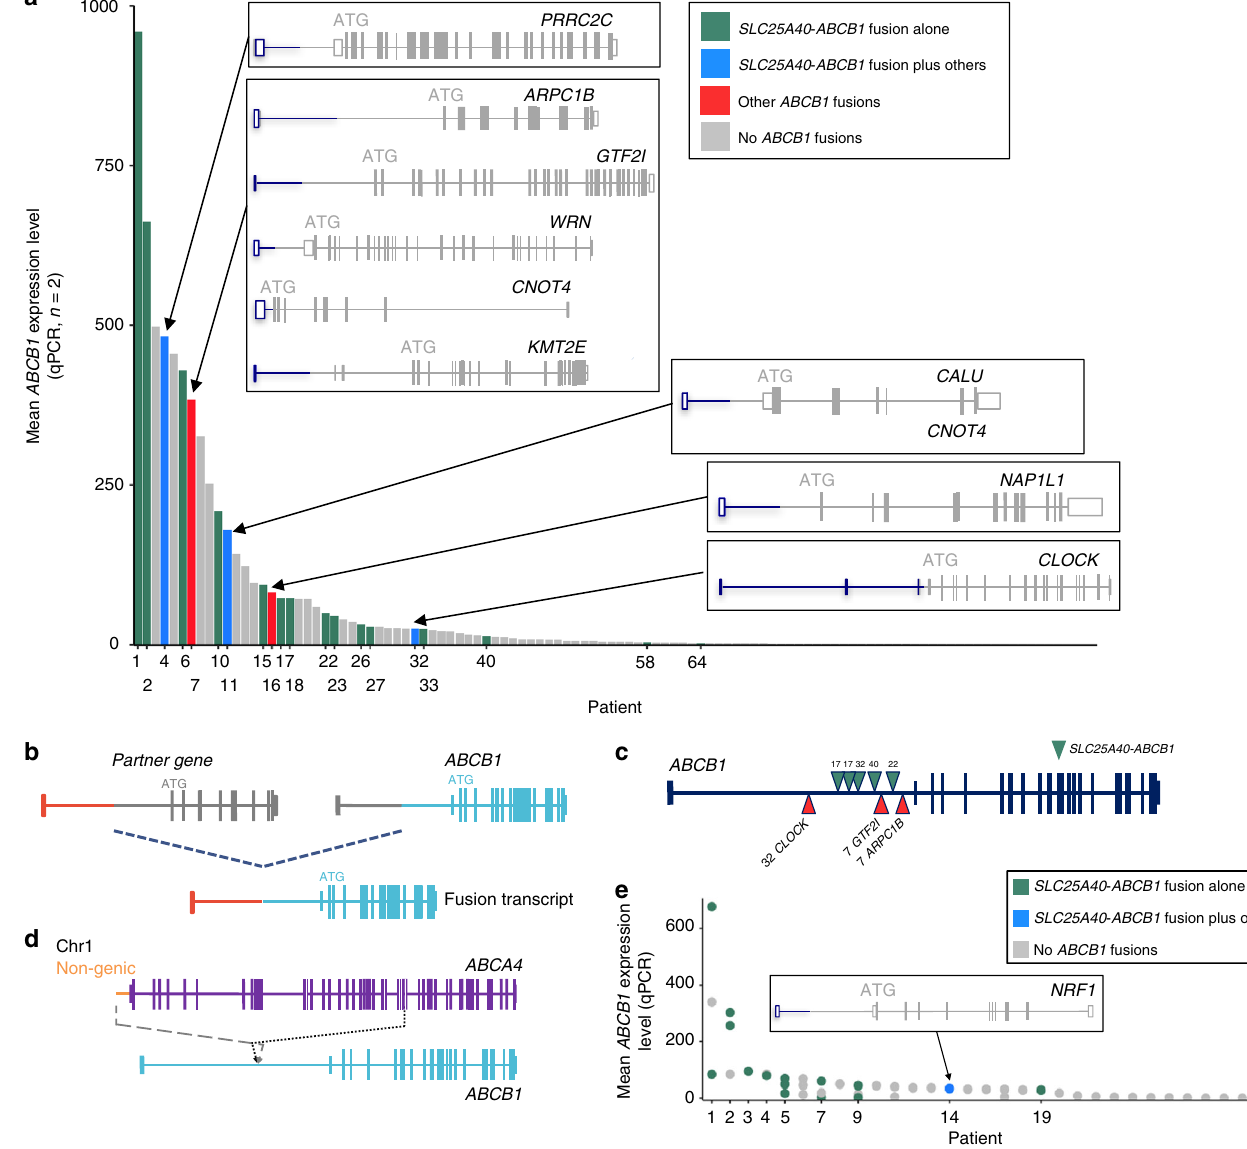
Fig. 1 ABCB1 in recurrent HGSC and breast cancer patients. a Patients ranked by ABCB1 expression level in recurrent HGSC samples ( n = 108), presence of ABCB1 transcriptional fusions was observed in 20 patients, the bar colour indicates the fusions present. Gene structure of 10 of the 13 fusion partner genes is shown. b Schematic representation of the structure of a majority of the transcriptional fusions identi fi ed in which non-coding exons of partner genes (red) were fused to exon 2 onwards of ABCB1 (green) . c Clustering of breakpoints at the 3 ′ end of intron 1 of ABCB1 , green triangles indicate SLC25A40 – ABCB1 fusion breakpoints, red are other fusion partners. d Schematic representation of the structure of the SV involving ABCB1 in Patient 9. e Breast cancer patients ranked by ABCB1 expression in recurrent or end-stage samples ( n = 30 patients, 45 samples). ABCB1 fusions were observed in nine patients (blue or green